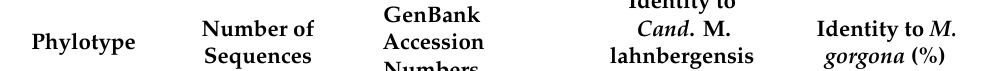
Table 2. The phylotypes of pmoA gene sequences retrieved from lichen-dominated tundra